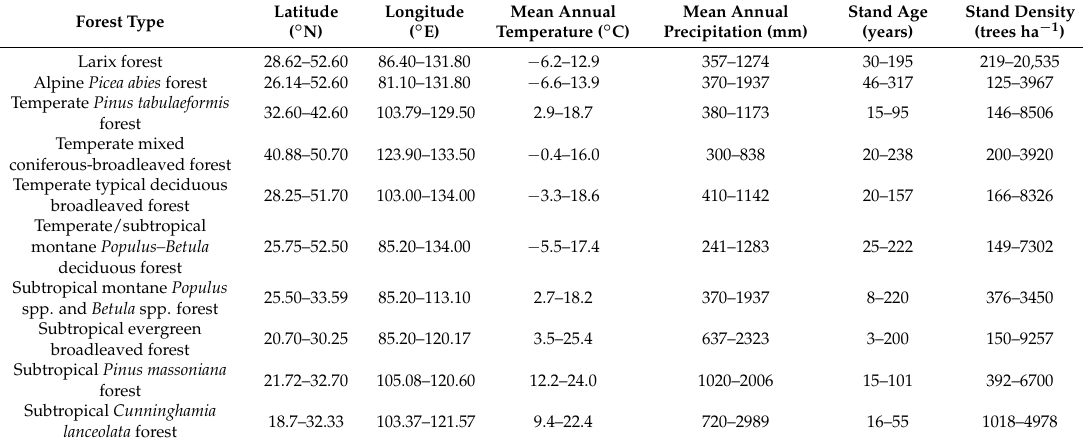
Table 1. Site conditions (longitude, latitude), climate factors (mean annual temperature (MAT), mean annual precipitation (MAP)) and forest characteristics (stand age, stand density) of the studied forest